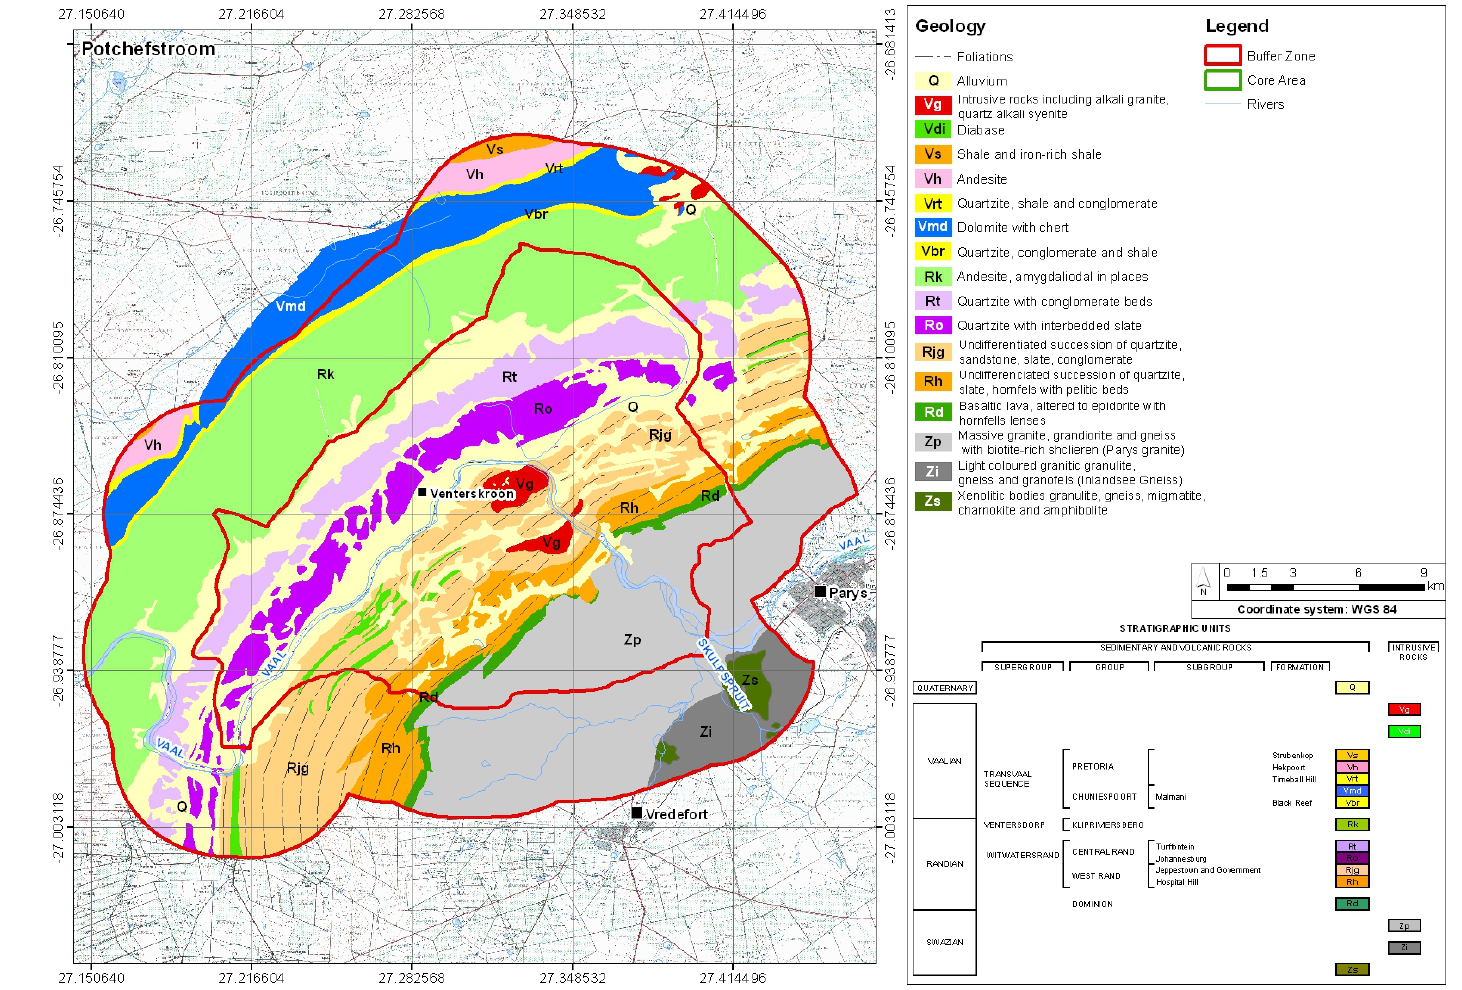
Figure 2. Geology of the